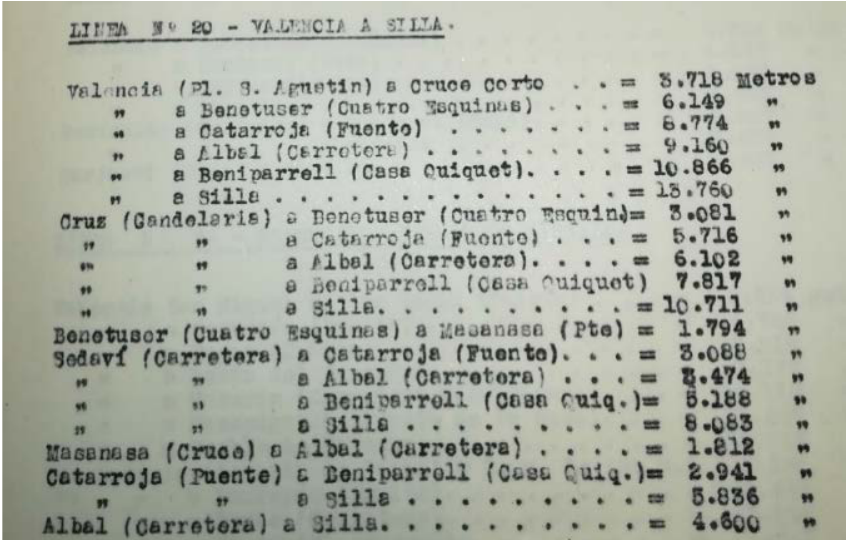
Figure 4. Example of the documentation found for the location of tram stops. Source: Valencian Regional Government Railways’ Historical Archive .